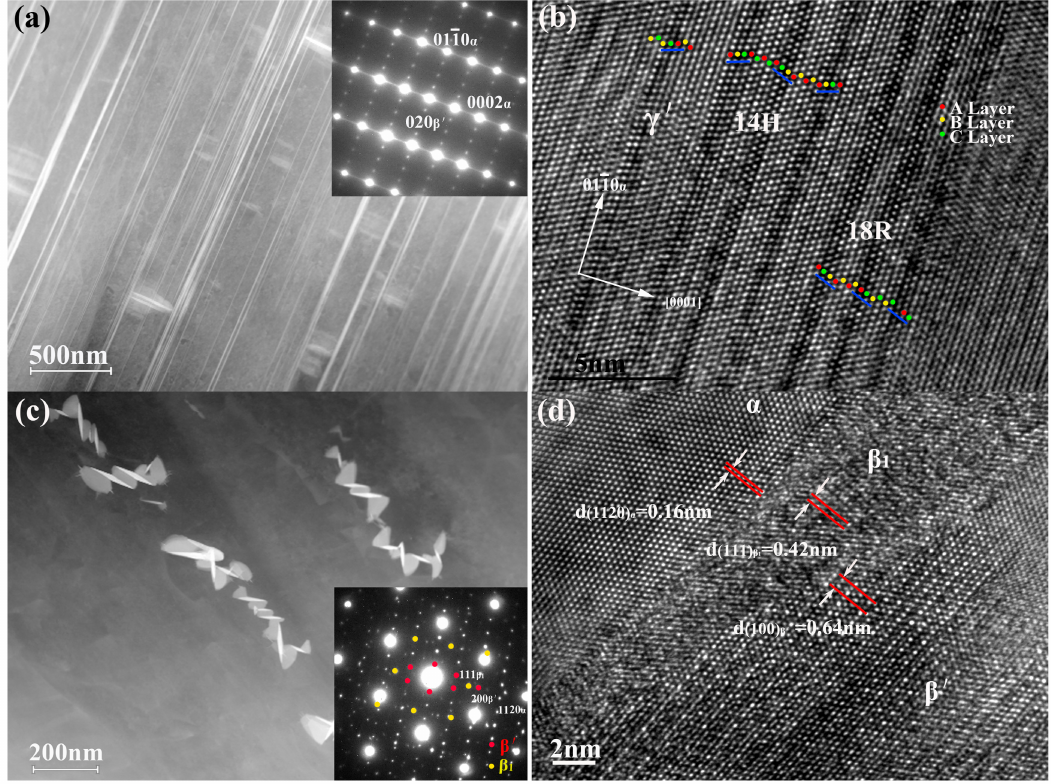
(cid:2) (cid:3) α ( c ) HAADF 2110